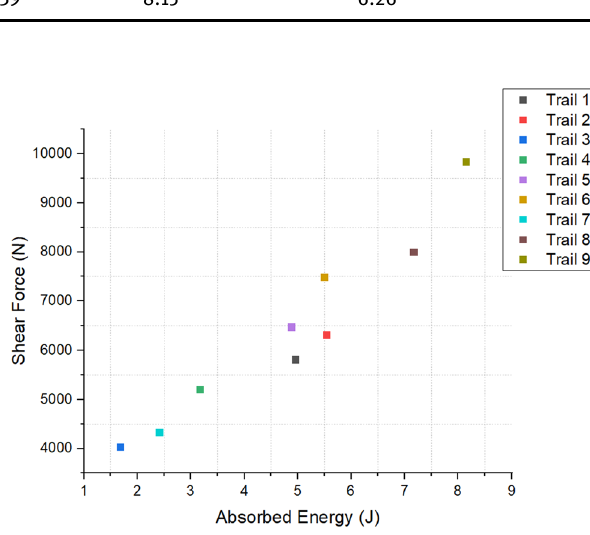
Figure 13: Tensile shear results for single spot welding.